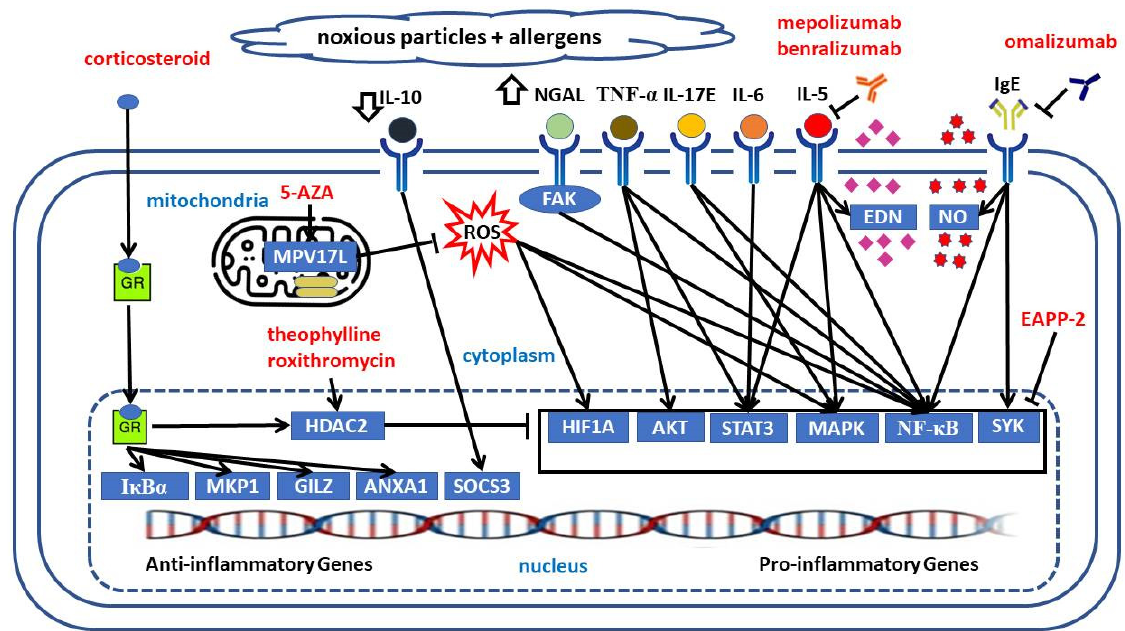
Figure 2. Potential medicines, including epigenetic drugs, and their actions on regulating pro-inflammatory or anti-inflammatory responses in asthma and chronic obstructive pulmonary disease overlap.